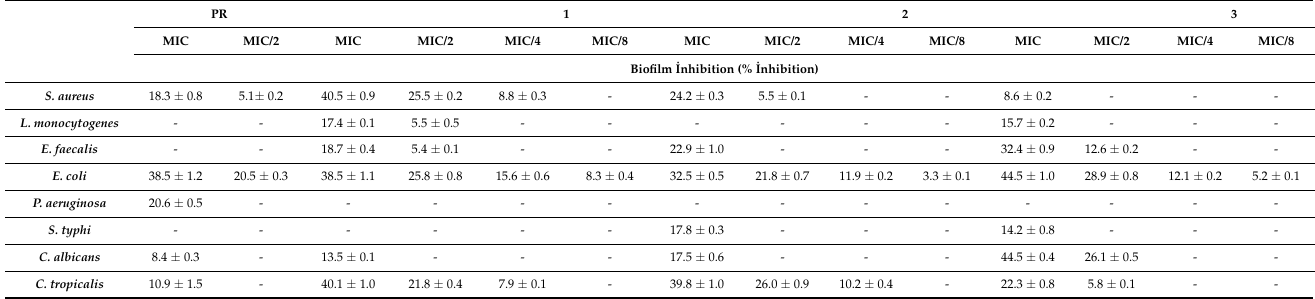
Table 8. Antibiofilm activities of propolis extract and isolated compounds (%